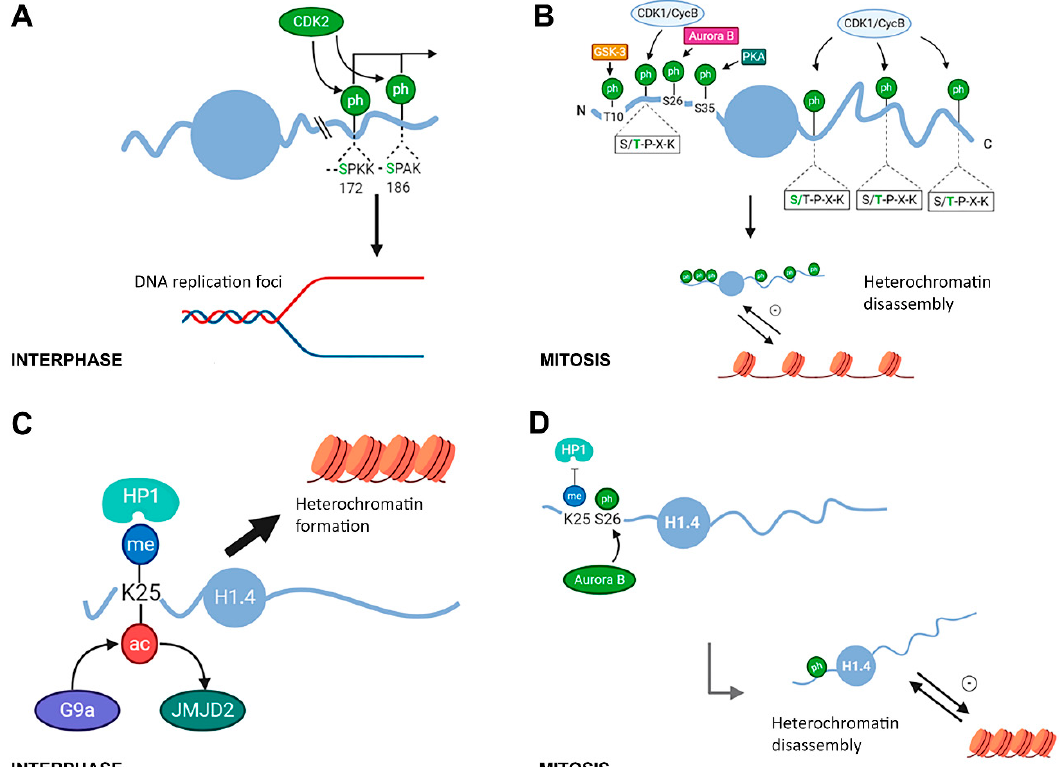
Figure 4. Modifications in histone H1 associated with chromatin compaction during the cell cycle. ( A ) In interphase, some CDK consensus motifs are phosphorylated presumably by CDK2. H1.2S172p and H1.4S186p have been linked to active transcription by RNAP I and II sites [40]. H1.5S172p and H1.2S172p have been shown